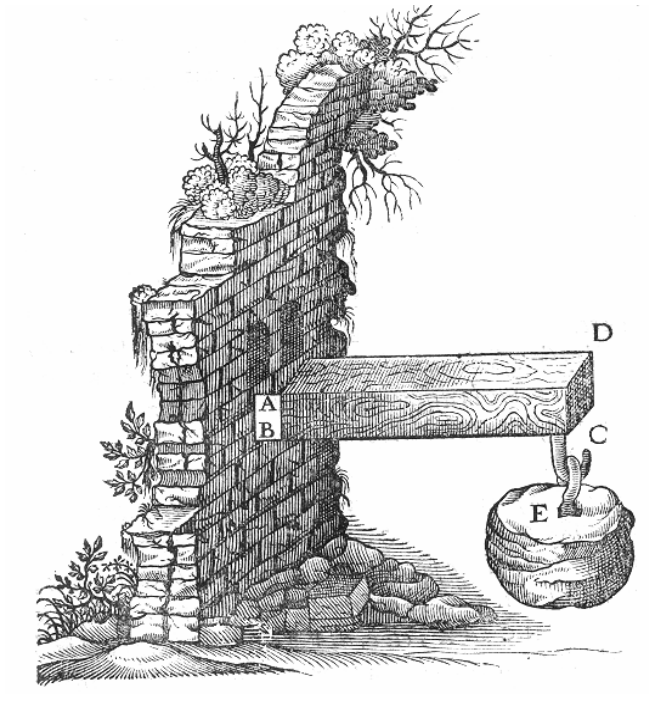
Figura 2. Prova di flessione di una trave (Galilei [5], p.